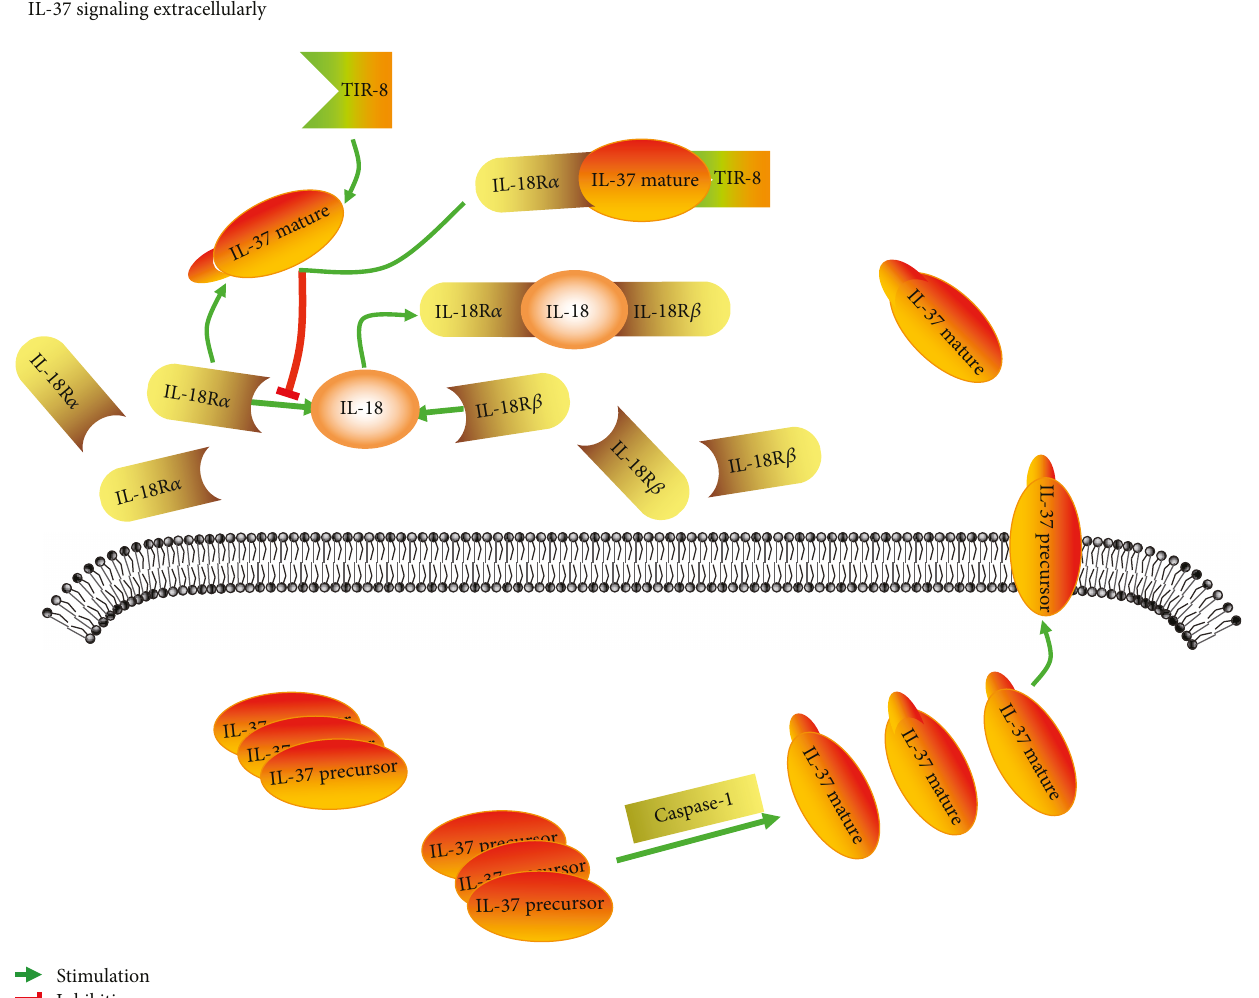
Figure 2: IL-37 is a “ dual function ” anti-in fl ammation cytokine. IL-37 exerts a biological role extracellularly. The IL-37 precursor is exported from the cell into the extracellular space to take a series of biological e ff ects. IL-18 binds to IL-18R α at the cell surface and recruits the IL-18R β chain to form a functional complex. IL-37 is combined with IL-18R α side chain to prevent the formation of IL-18 functional